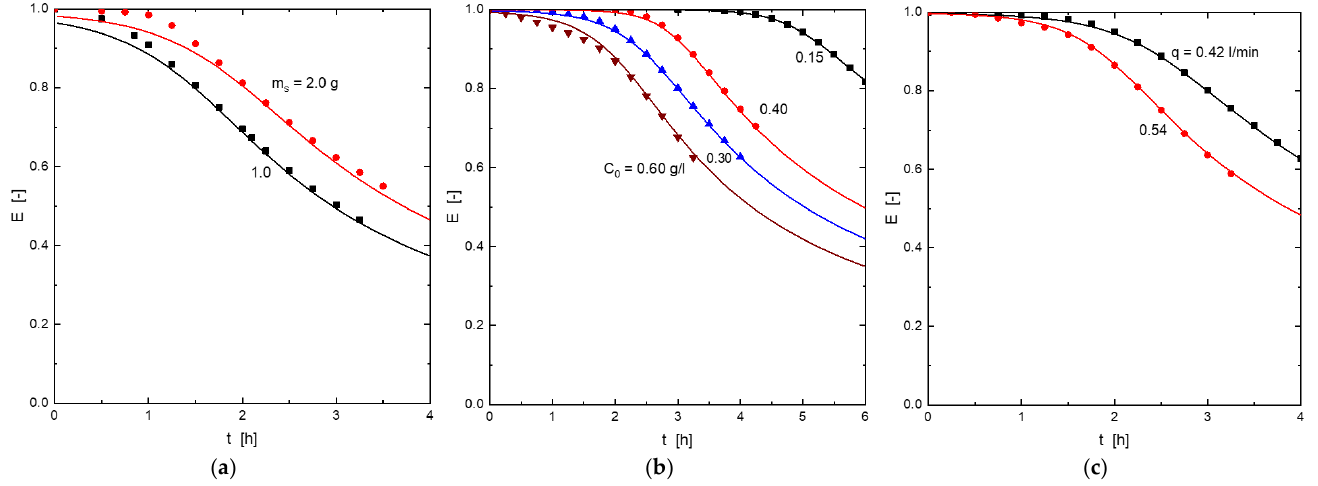
Figure 7. Experimental (symbols) and model (Equation (10)) (lines) column efficiencies. ( a ) Influence of the adsorbent dosage. ( b ) Influence of the H 2 S concentration in the gas mixture. ( c ) Influence of the gas mixture flow.